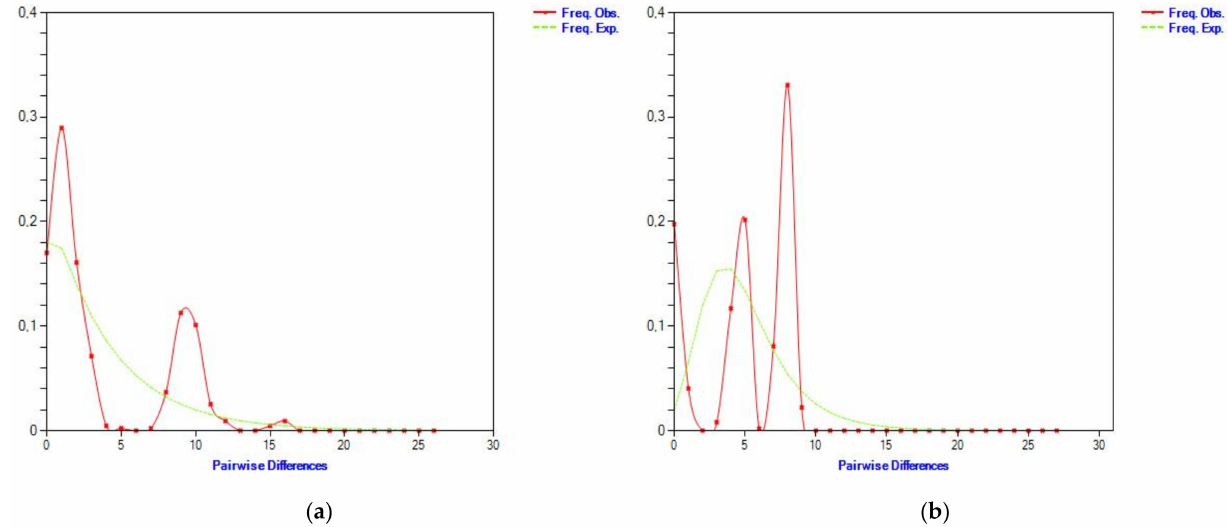
Figure 5. Demographic expansion of Grey Steppe population: ( a ) cytochrome b; ( b )